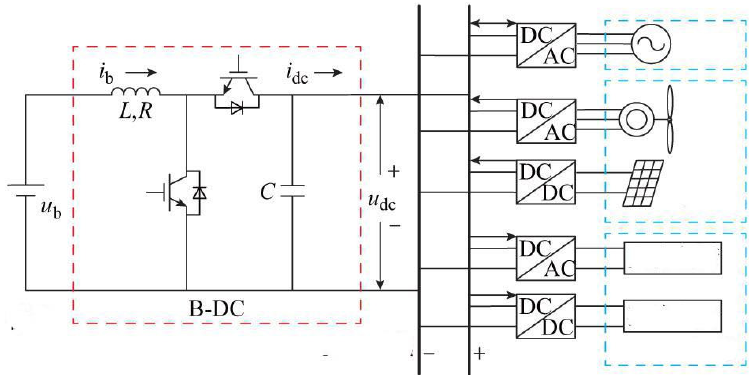
Figure 2. Structure Diagram of a DC Microgrid with a